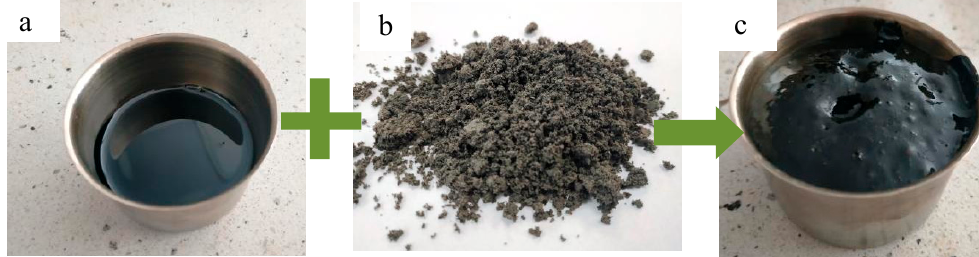
Figure 3. ( a ) 20 grams of 20/30 asphalt in a temperature of 135 °C; ( b ) Na-P1 zeolite soaked with water; ( c ) foaming effect of asphalt caused by water releasing from the zeolite.